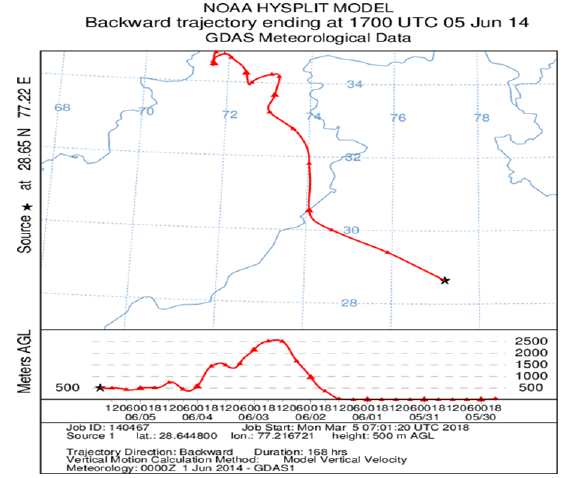
Figure 10: Backward Wind Trajectory, June 2014